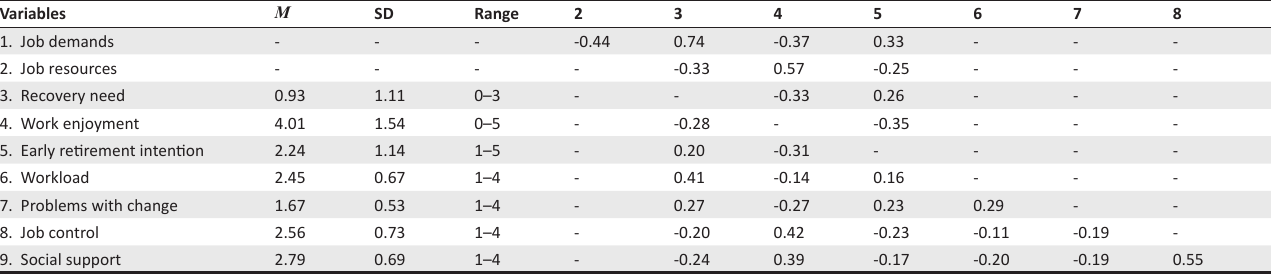
TABLE 1: Means, standard deviations, ranges and correlations amongst the study variables ( N = 1812). Variables M